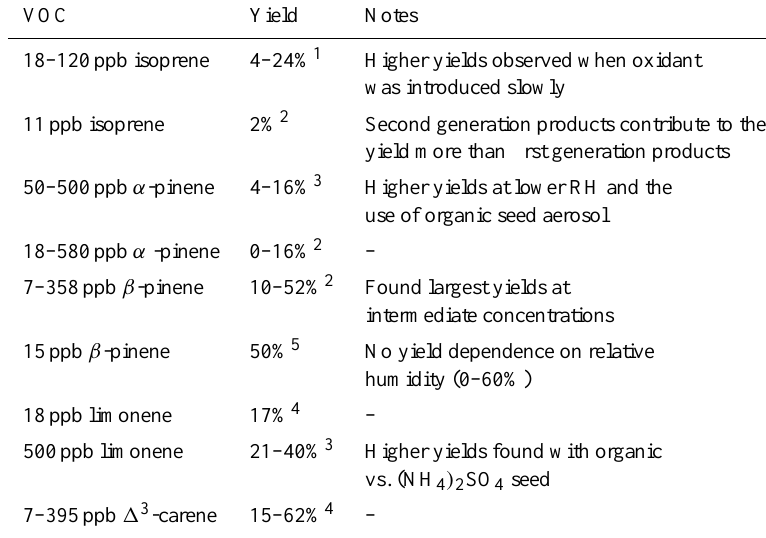
Table 1. SOA yields for NO 3 -initiated experiments.